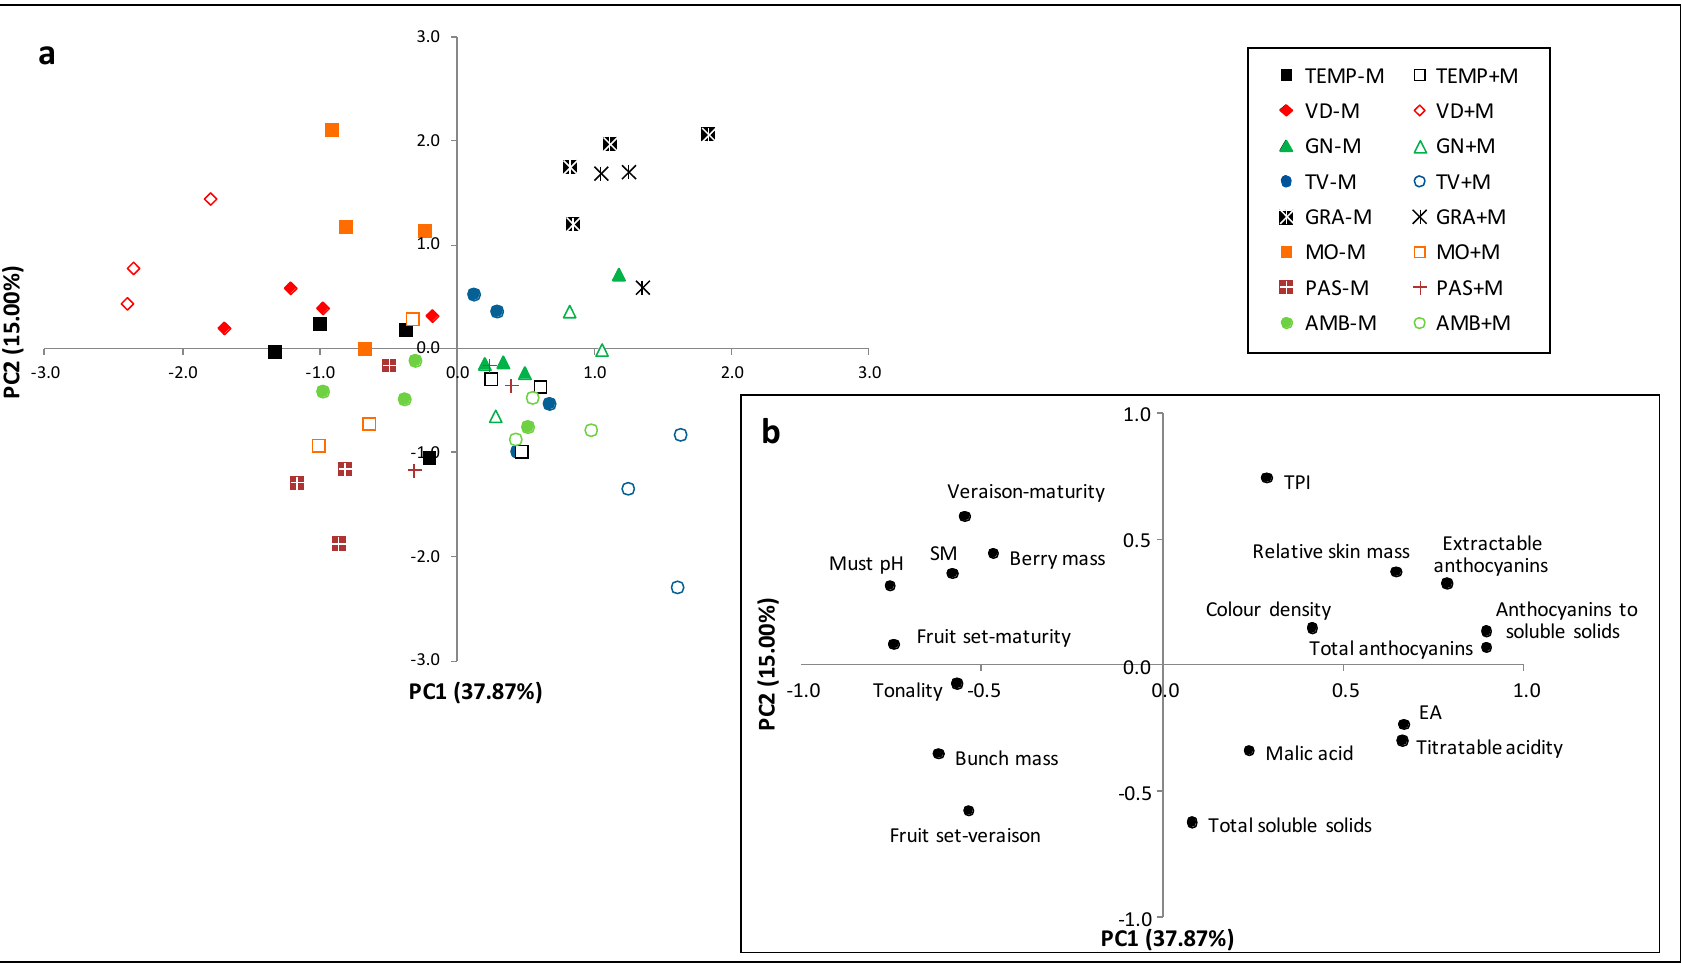
Figure 2. Principal component analysis score ( a ) and loading plot ( b ) obtained from the statistical analysis of plant and berry characteristics data of 56 studied samples from fruit-bearing cu tt ings of some ancient grapevine varieties inoculated with arbuscular mycorrhizal fungi (+M) or uninoculated ( − M).